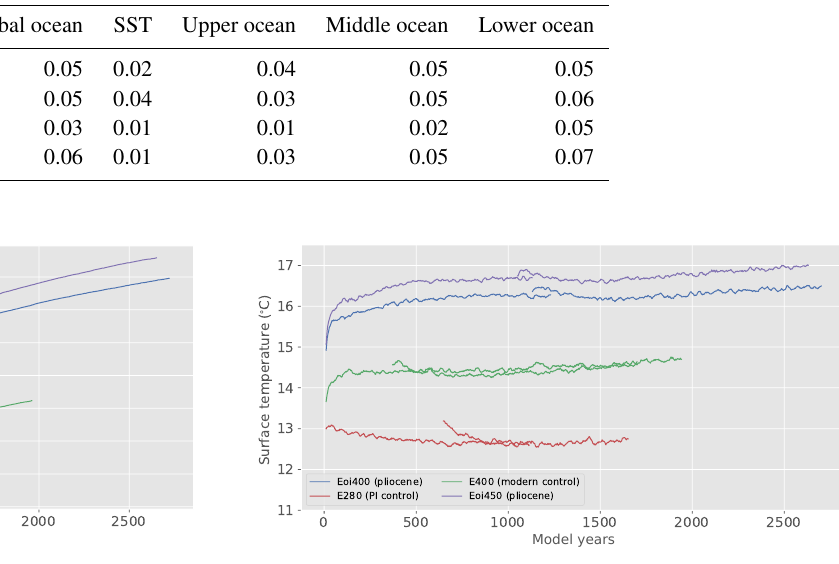
Figure 4. Similar to Fig. 3 but showing the evolution of the globally averaged ocean temperature.